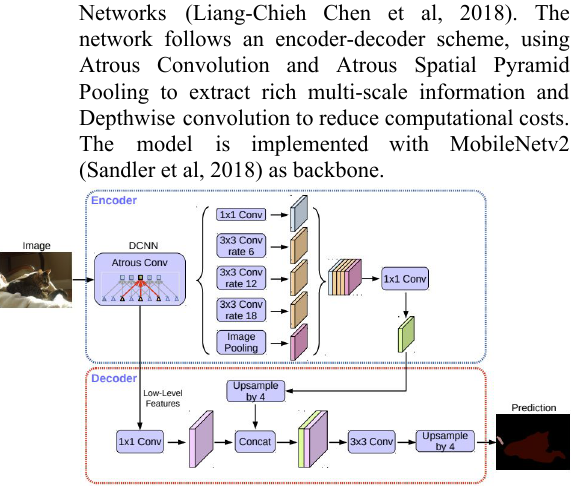
Figure 4. Deeplab V3+ architecture